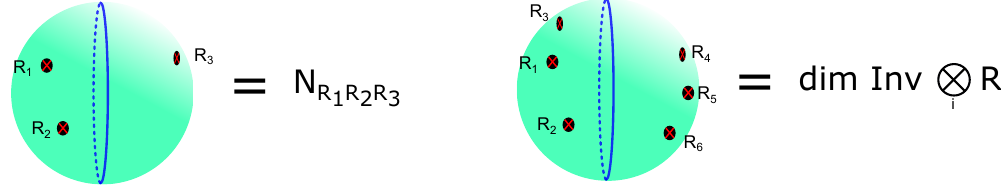
Figure 10 . Example of a bulk knot with three local e i(cid:12) (cid:8)( y i ) punctures.